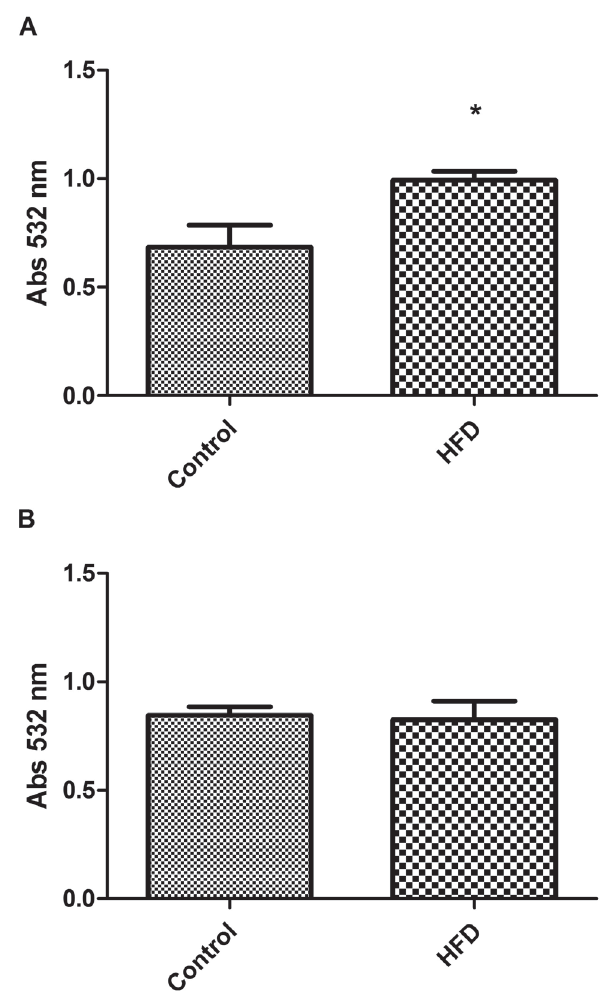
FIGURE 7 - Lipid peroxidation determination of kidney membrane preparation of HFD mice. Right (A) and left (B) kidney membrane preparations were used. The experiments were performed in triplicate. * Significant difference between the group under treatment and control group (p<0.05).